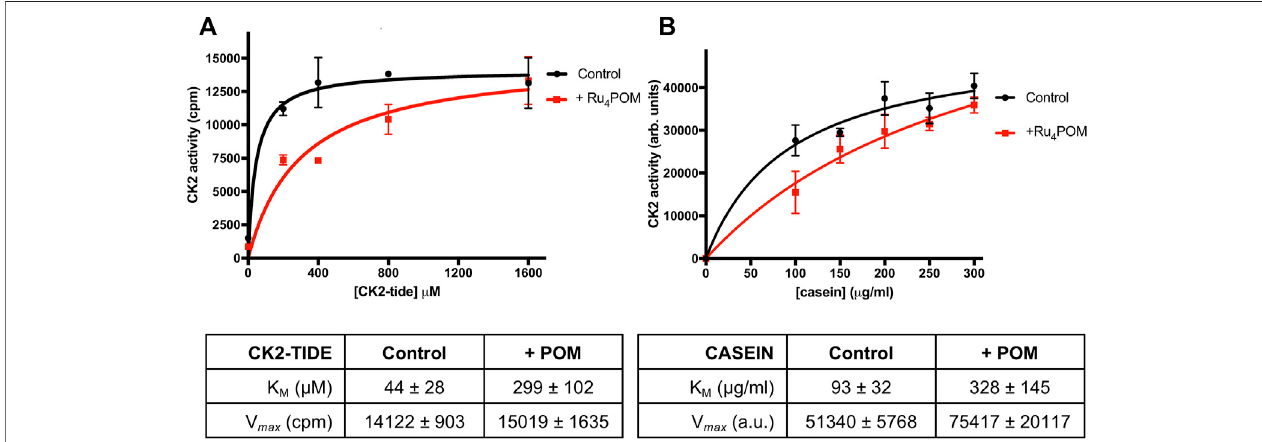
FIGURE 2 | Substrate-competitive inhibition. (A) CK2 activity was measured by radioactive phosphorylation assays, with increasing concentrations of CK2-tide peptide, in the absence or presence of 5 nM Ru 4 POM. Radioactivity was detected by scintillation counting (cpm). (B) CK2 activity was measured by radioactive phosphorylationassays,withincreasing concentrationsofcasein, intheabsenceorpresenceof18 nM Ru 4 POM. Radioactivity wasdetected bydigitalautoradiography (arbitraryunits).Atleasttwoindependentexperimentswereperformed.Meanvalues±SEMarereportedinthegraphs;thetablesonthebottomreportthekinetics parameters ± SEM calculated by Michaelis-Menten analysis.